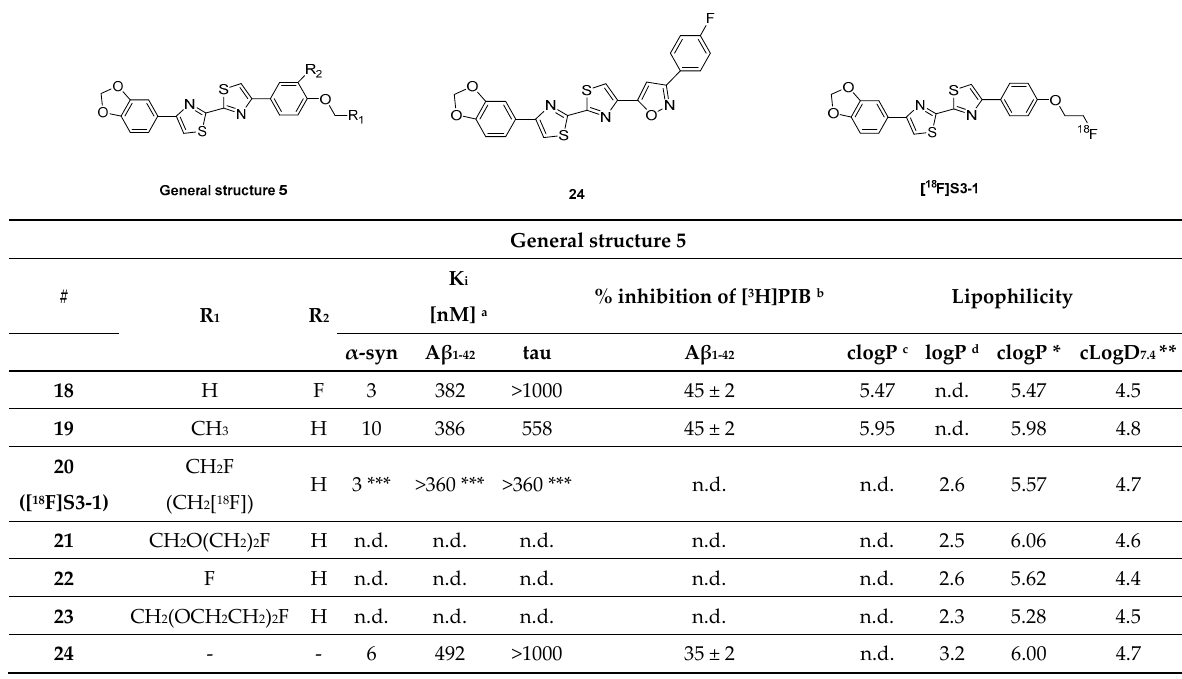
Figure 14. Chemical structures of bithiazole derivatives with key properties. Chemical structure of potential α -syn ligands with binding properties toward recombinant α -syn, A β 1-42 , and tau fibrils. a Affinity toward α -syn fibrils, synthetic amyloid peptides (A β 1-42 ) and human recombinant tau-441 determined by saturation binding assay [107]. b % inhibition of [ 3 H]PIB determined by competition binding assay [107]. c calculated clogP according to the reference [107]. d Measured logP from octanol/PBS study according to the reference [107]. n.d.: not determined. * clogP values were calculated by BioByte. ** clogD 7.4 values calculated by ACD/Percepta. *** Literature source [108].